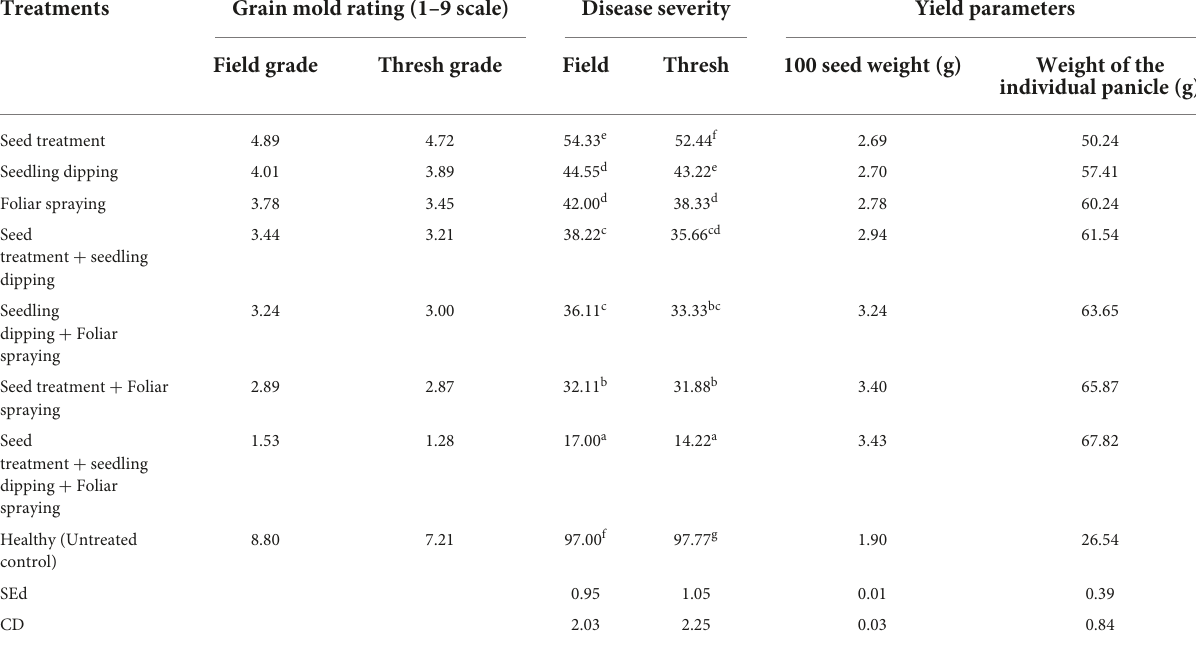
TABLE 2 Evaluation for S. rochei against grain mold pathogens under glasshouse